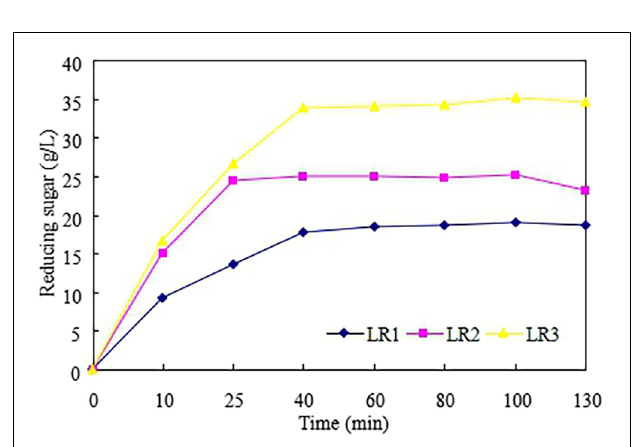
FIGURE 3 | Production of reducing sugar in the enzymatic hydrolysis of leftover cooked rice.